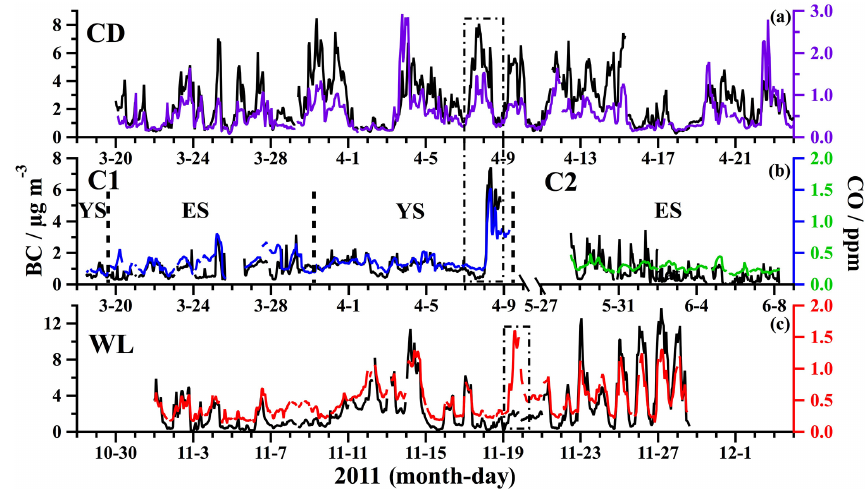
Figure 3. The time series of BC (the black lines) and CO (the lines coded by other colors) during the campaigns of Changdao Island (a) , two cruises (b) , and Wenling (c)